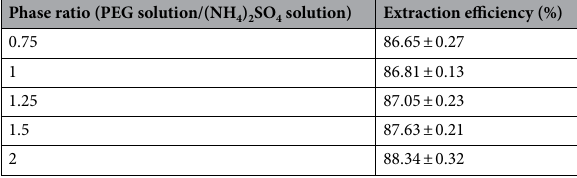
Table 2. Effect of phase ratio on the extraction of Co(II) (T = 25 °C; Time = 15 min; Co(II) = 500 ppm, PEG = 50% w/w, pH = 2).